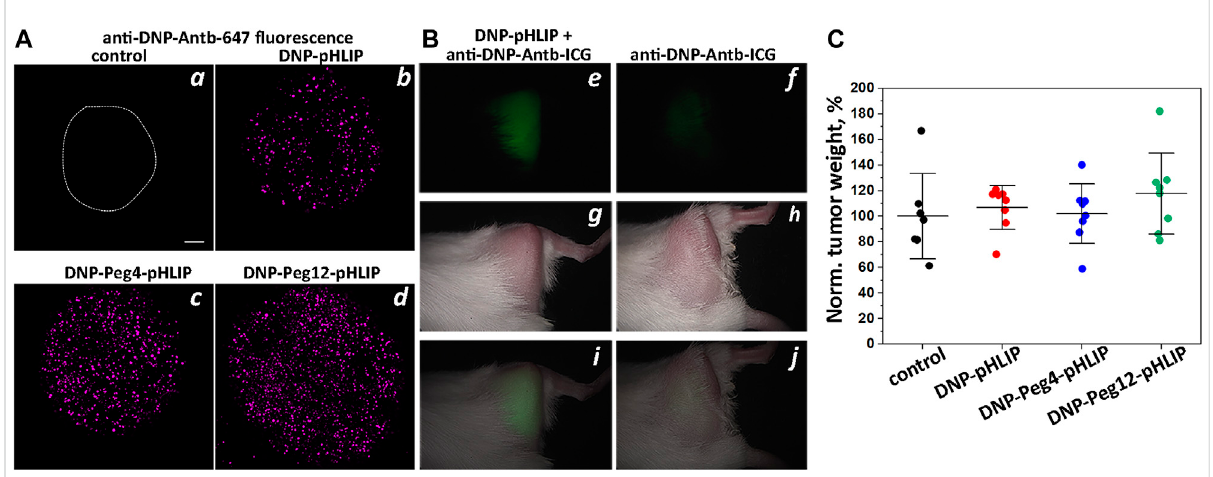
FIGURE 1 DNP-pHLIP in tumor spheroids and mice. Antibody binding and therapeutic performance of DNP-pHLIP agents as investigated in tumor spheroids (A) and in mice (B,C) . (A) HeLa tumor spheroids were treated with medium (the contour of the spheroid is outlined) (a), DNP-pHLIP (b), DNP-Peg4-pHLIP (c) and DNP-Peg12-pHLIP (d), followed by washing and incubation with anti-DNP-Antb-647. Finally, tumor spheroids were washed and imaged with a confocal microscope using a ×10 objective. A 100 μ m scale bar is shown. Representative fl uorescence images are shownin(a – d). (B) Representative invivo NIR fl uorescence(e,i),visiblelightphotograph(g,h)andoverlayof fl uorescenceandphotograph(i,j)images obtained 24-hafterasingleIPinjectionofanti-DNP-Antb-ICGmixedwithDNP-Peg12-pHLIP (e,g,i) oranti-DNP-Antb-ICG (f,h,j)intoBalb/C female mice bearing 4T1 tumor in right (shaved) fl ank. (C) Normalized weights of murine Lewis lung carcinoma LLC1 tumors collected from C57Bl/6NHsd female mice immunized with KLH-DNP/CFA and KLH-DNP/IFA and treated with DNP-pHLIP, DNP-Peg4-pHLIP and DNP-Peg12-pHLIP are shown. The mean weight of the tumors in the control group was taken as